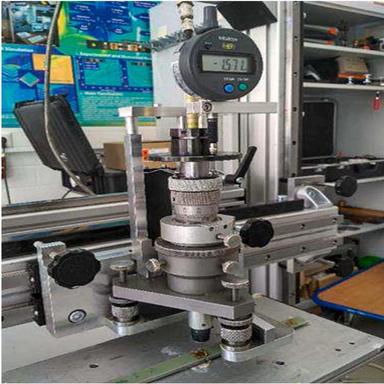
Experimental setup used for application of IHD.